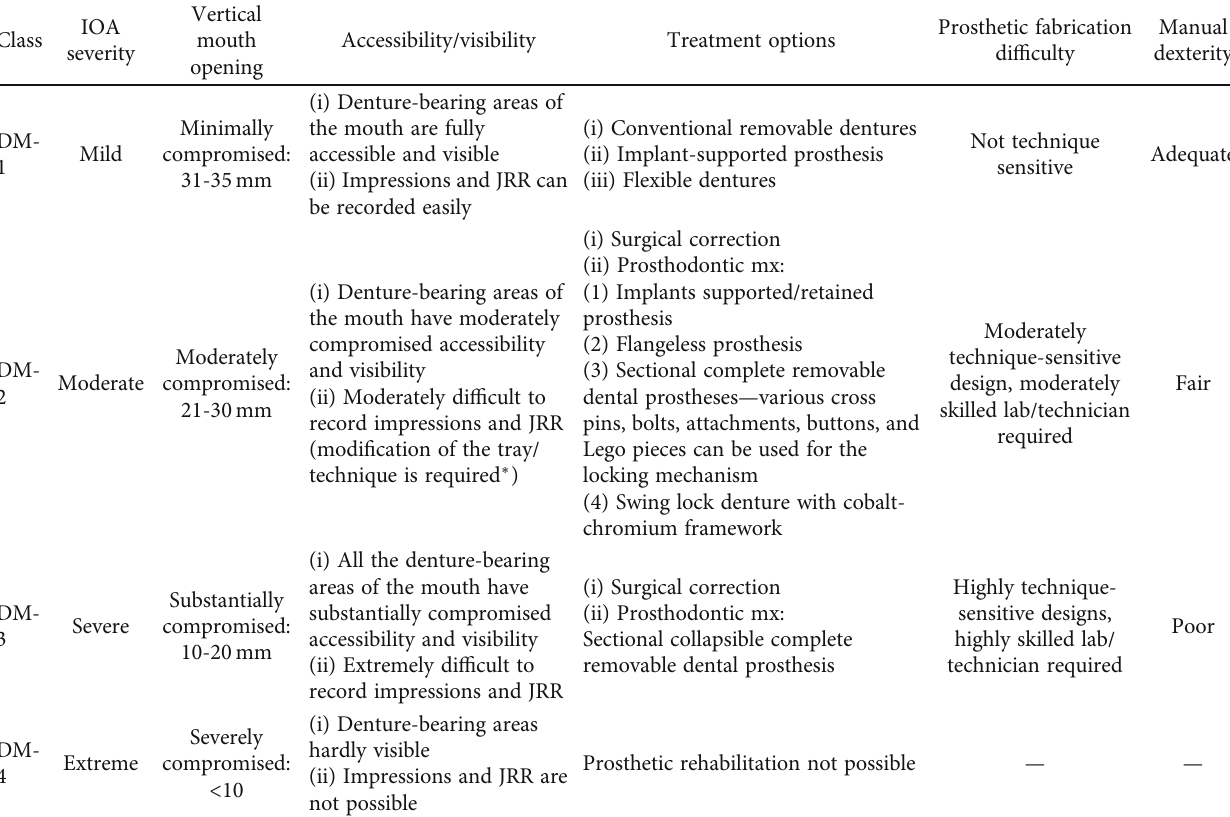
Table 1: Classi fi cation systems based on diagnosis and management for microstomia